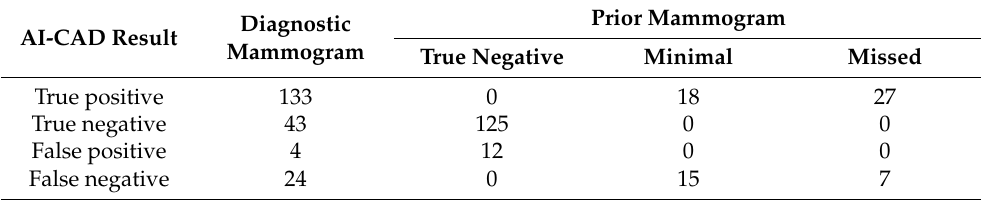
Table 2. AI-CAD results for diagnostic and prior mammograms.